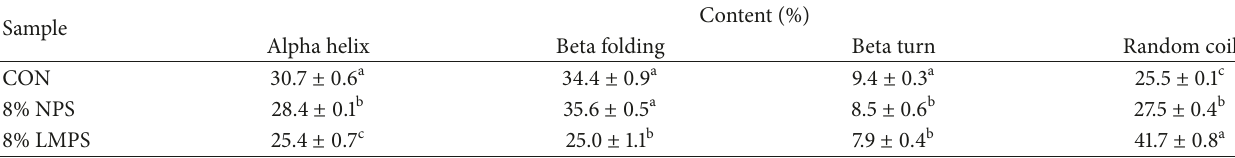
Table 3: Secondary protein structure content of Amide I.